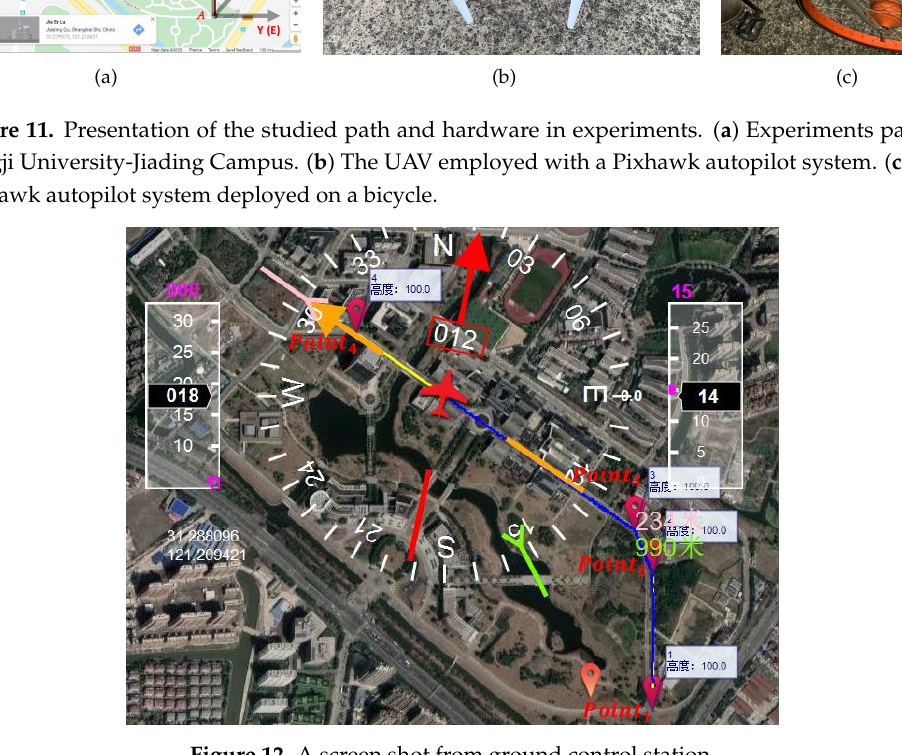
Figure 12. A screen shot from ground control